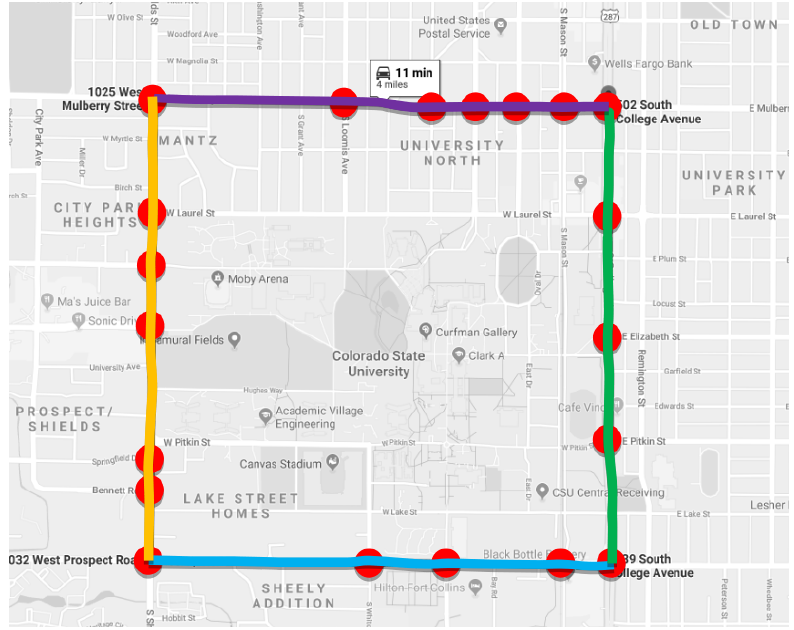
Figure 3. Selected data drive cycle; drive order was purple, yellow, blue, then green, red circles represent traffic